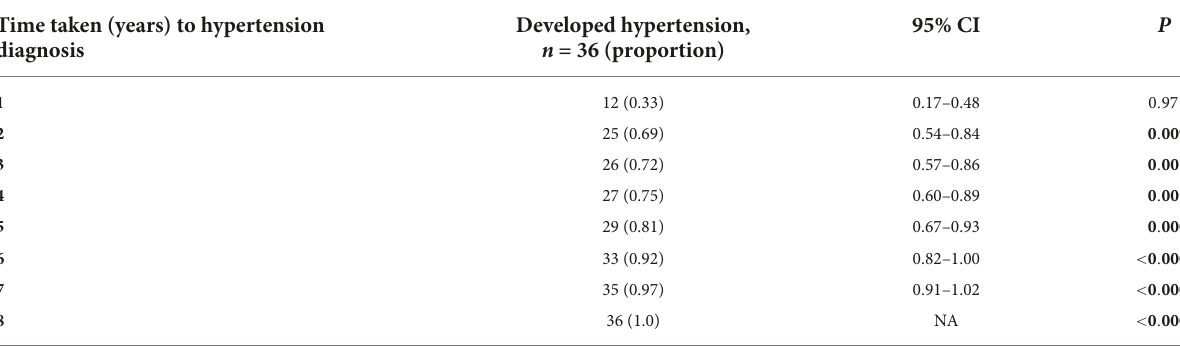
TABLE 2 Cumulative proportion of participants who developed hypertension at each time interval. Time taken (years) to hypertension diagnosis